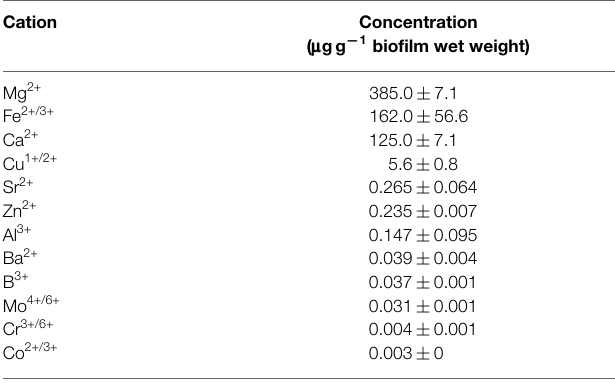
TABLE 1 | Concentration of multivalent cations in S. acidocaldarius biofilms cultivated on Brock medium plates at 78°C for 4days